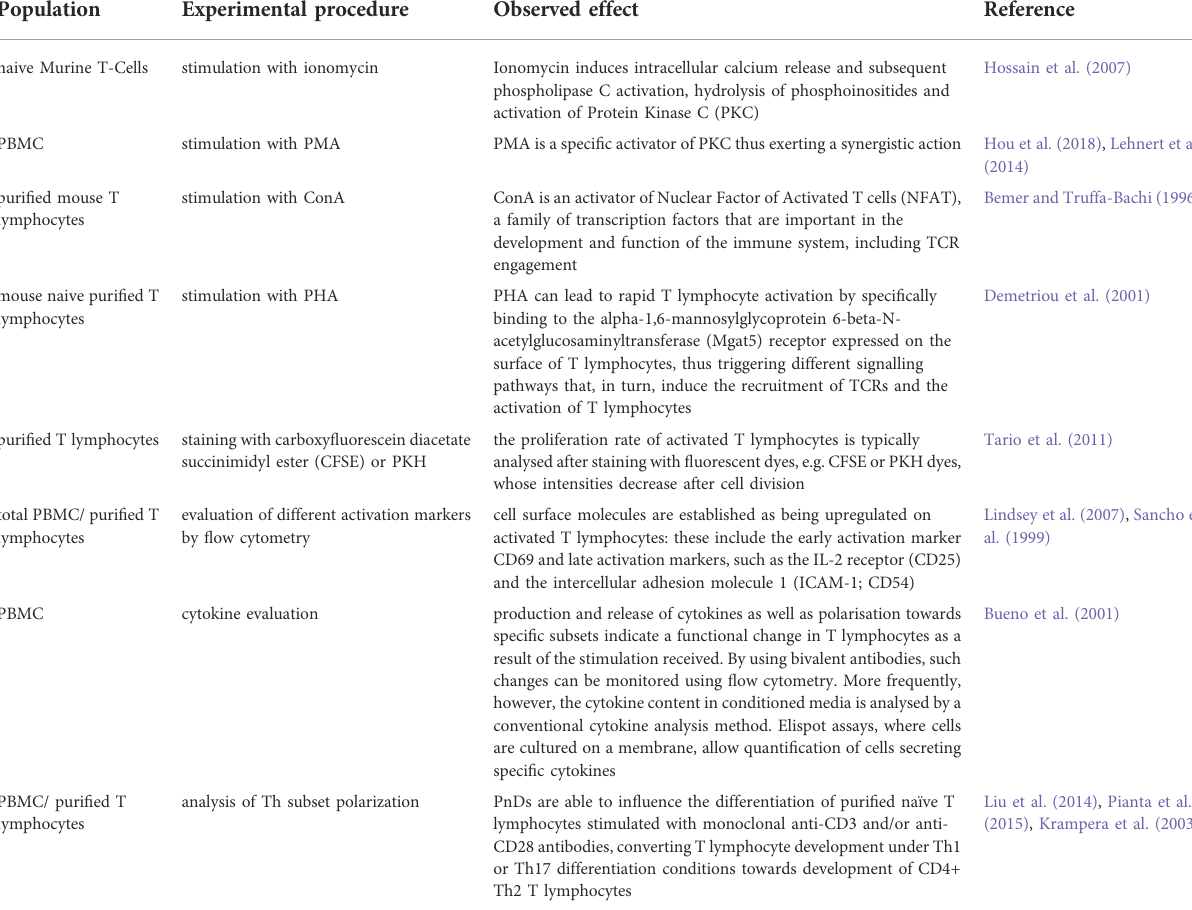
TABLE 2 Mechanism of action of the different stimuli and possible